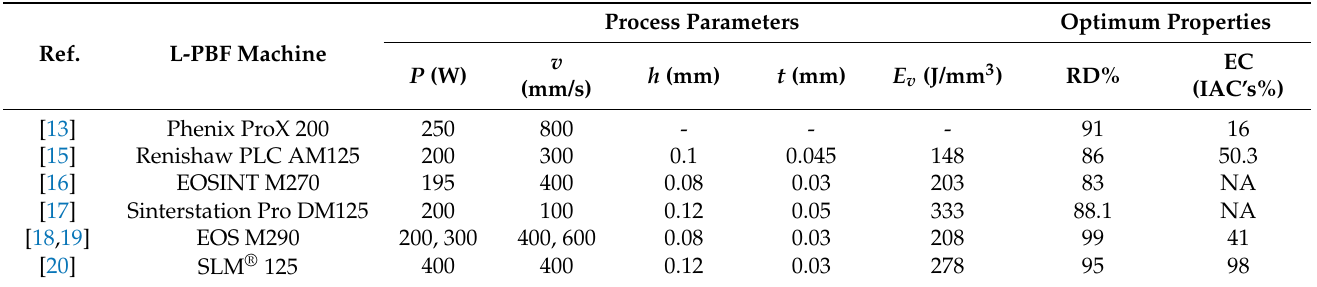
Table 1. Process parameters for printing copper parts made by commercial L-PBF machines and corresponding optimum properties.